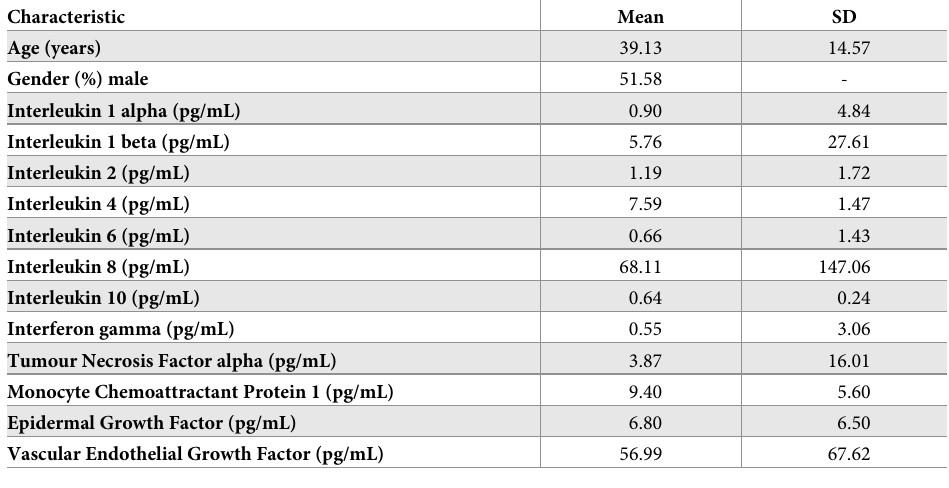
Table 1. Characteristics of the study population (n =